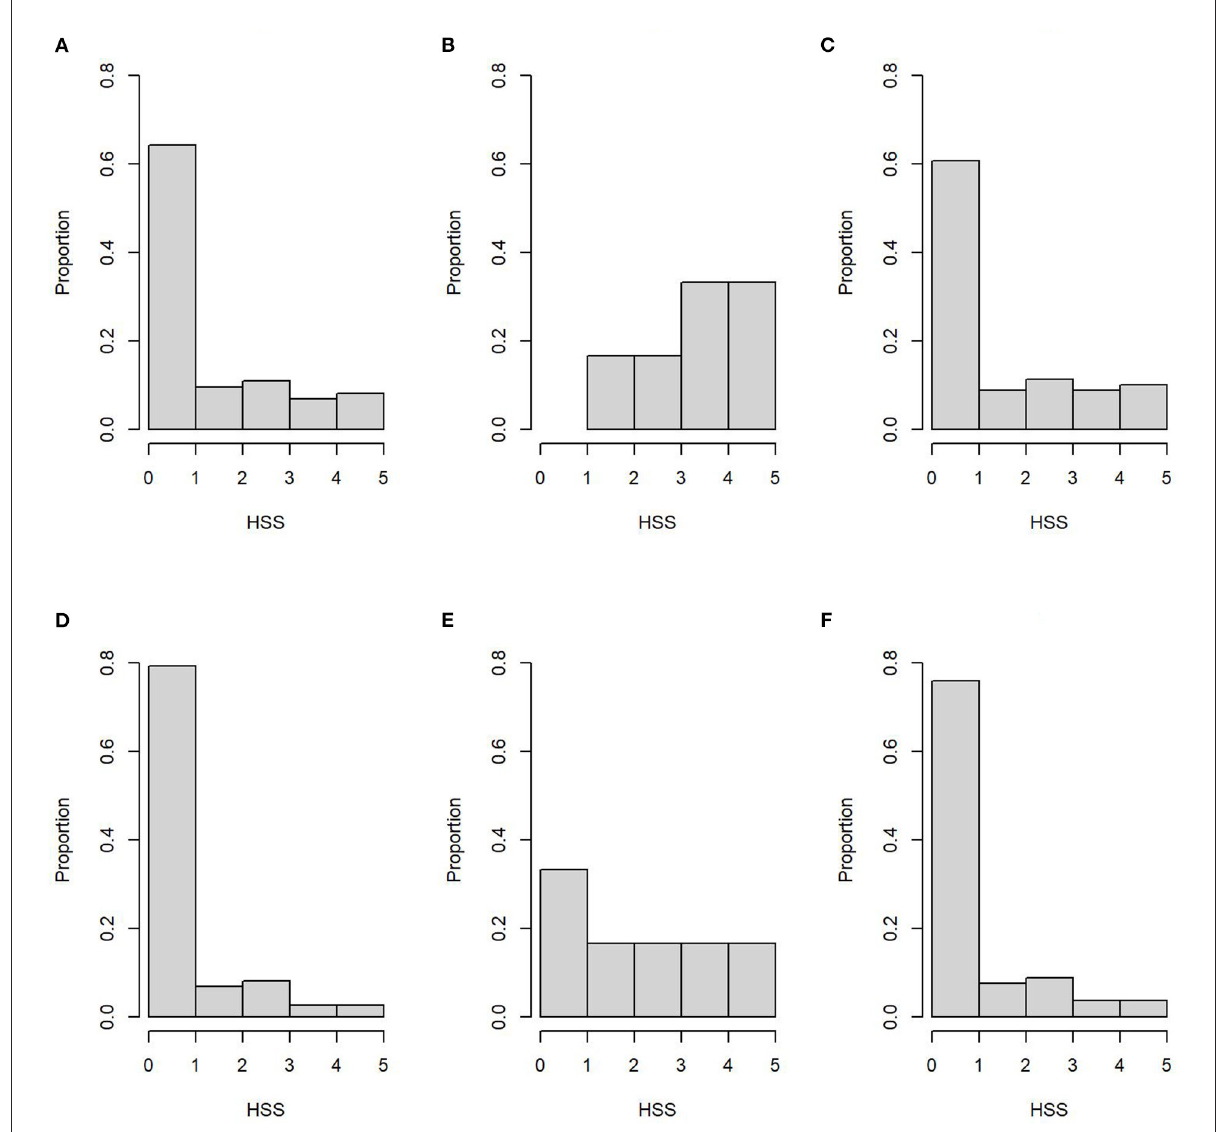
FIGURE2 Histopathology severity score (HSS) distribution of ileum samples (superior row) for the subpopulation 1 (A) , subpopulation 2 (B) , and both subpopulations (C) . Bottom row represents HSS distribution of mesenteric lymph nodes samples from subpopulation 1 (D) , subpopulation 2 (E) , and both subpopulations (F)